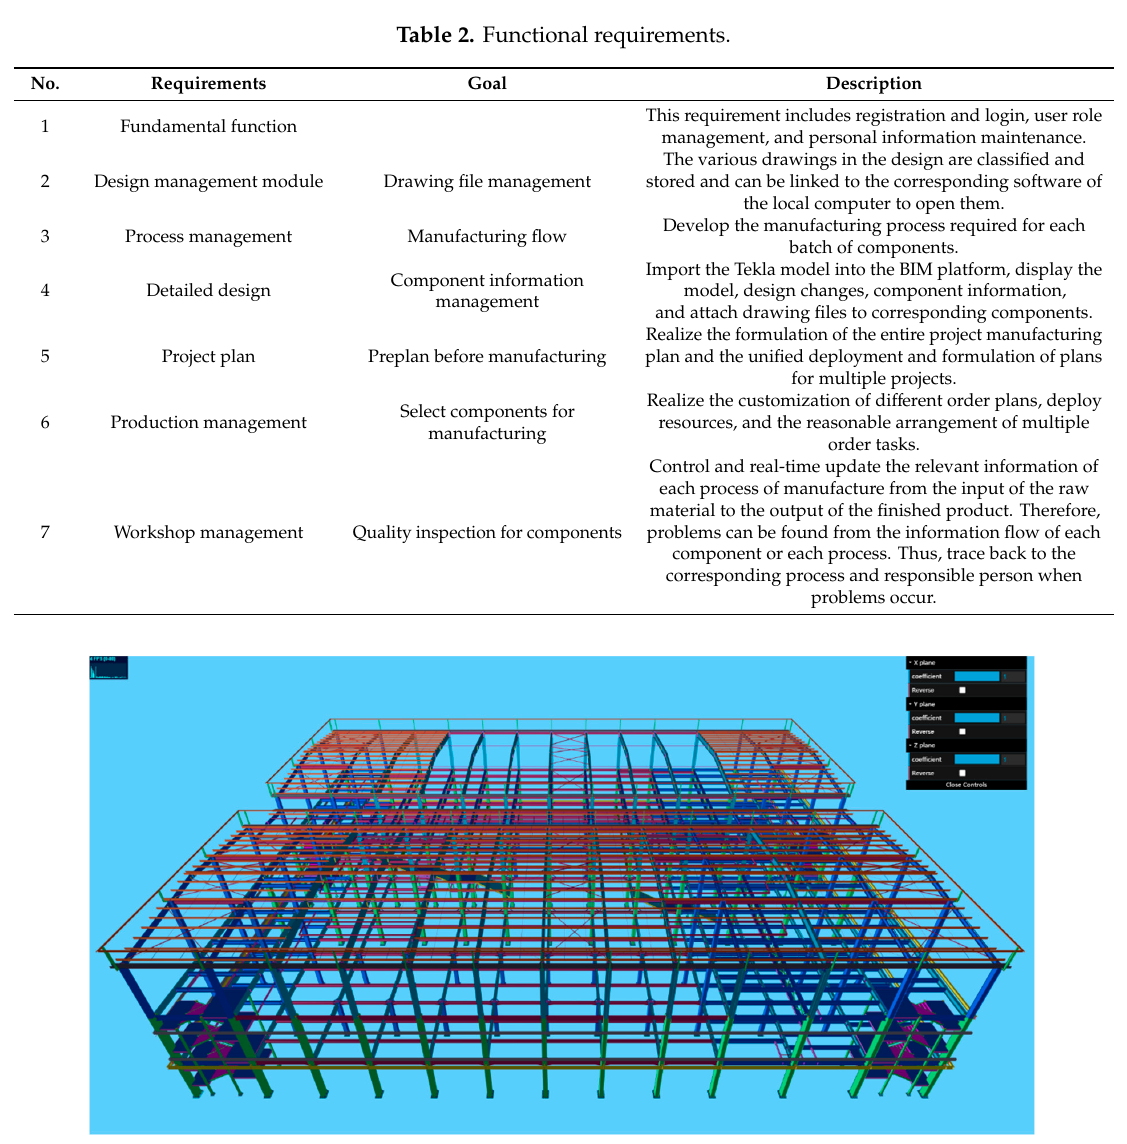
Figure 4. Lightweight processed model.